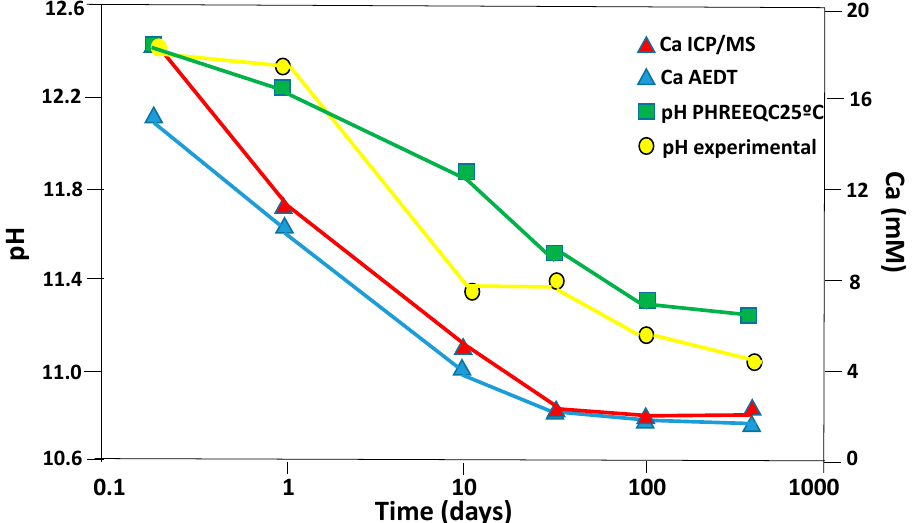
Figure 6. Behavior of Ca 2+ (aq.) concentration and pH using different measurement methods.